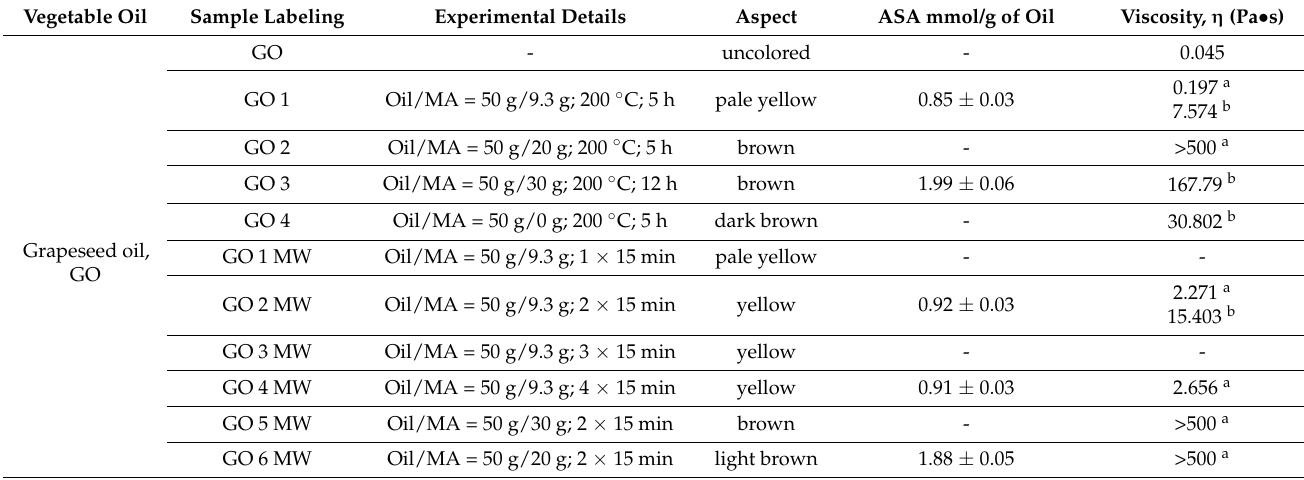
Table 3. Experimental details and some properties of the reaction products between the vegetable oils and maleic anhydride.